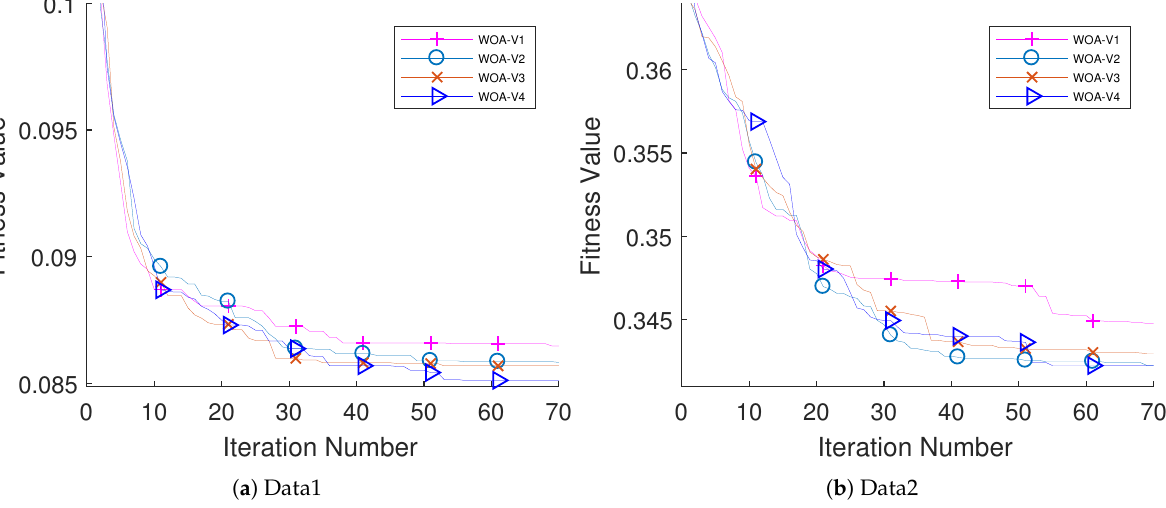
Figure 14. Convergence curves of WOA with different V-shaped